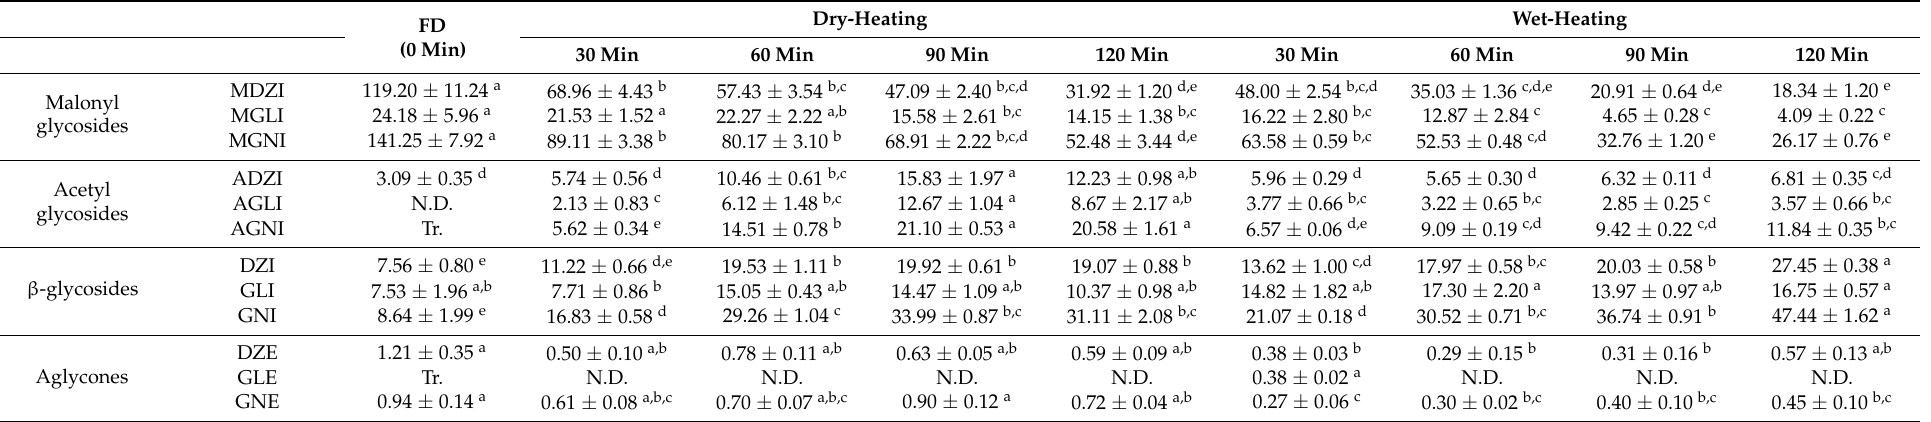
Table 3. Isoflavone content (mg/100 g DW) in mature soybeans during thermal